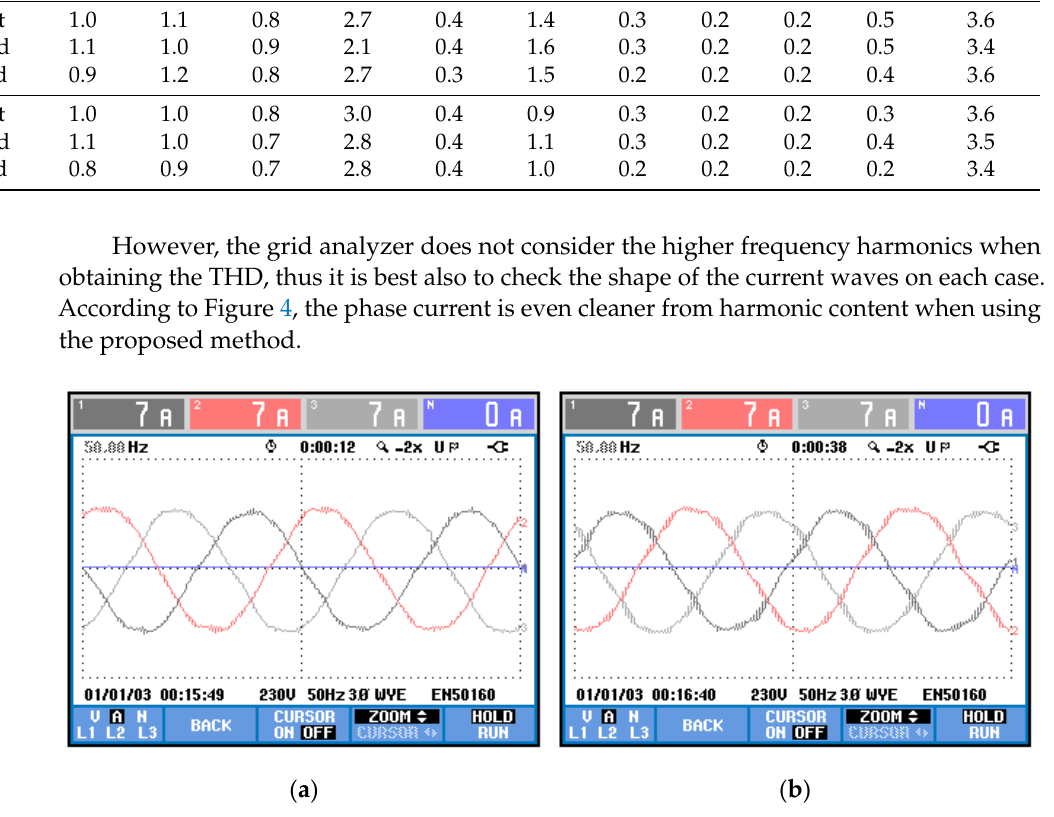
( b ) Figure 5. DC-Link voltage ripple: ( a ) proposed method; ( b ) state-of-the-art alternative. The plots show voltage (25 V/div) vs. time (10 ms/div). Figure 6 shows the modules switching for each method. The proposed method clearly has a lower number of commutations on all modules. This is so because the pro- posed method only considers phase-to-phase voltages when solving the LOP. Thus, it be- haves more similarly to the space vector modulation, with two commutations per control cycle (instead of 3). The state-of-the-art alternative, on the other hand, considers the volt- age of each phase separately, thus having three commutations per control cycle. In general, it can be said that the proposed method can achieve the same ripple and better quality current than the state-of-the-art alternative with a reduced amount of com- mutations.